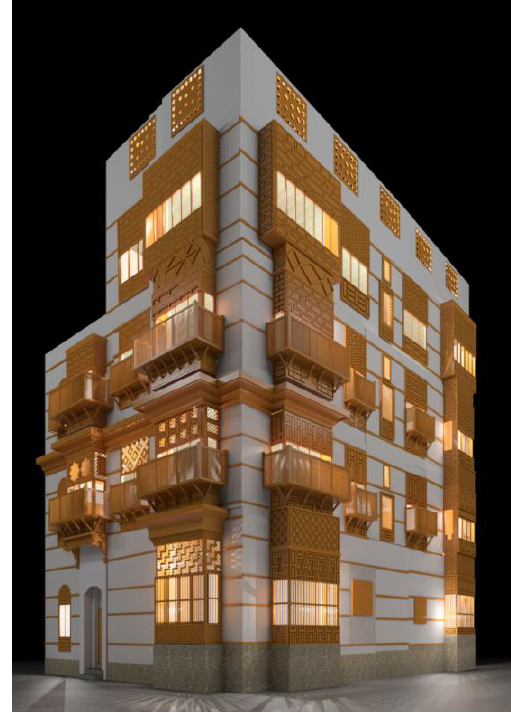
Figure 3. Point cloud registration.